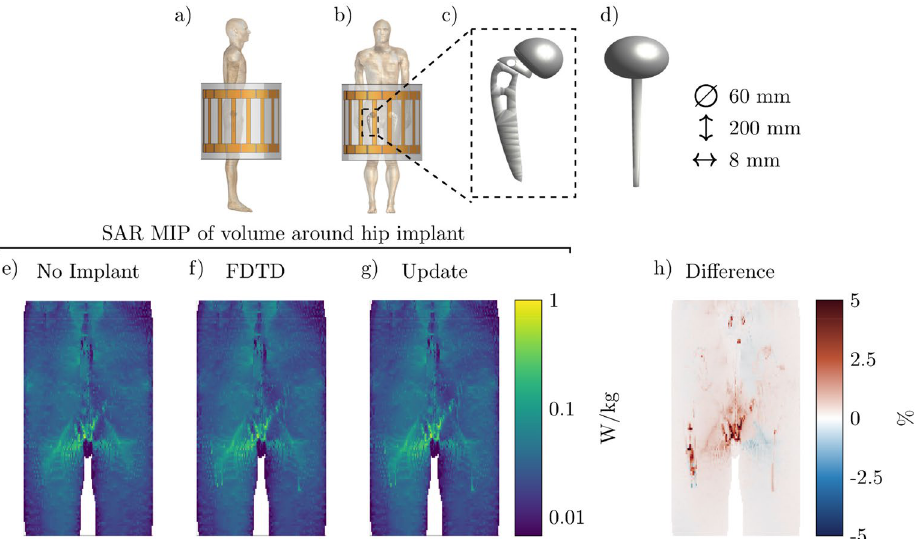
Figure 6. Proposed method applied to calculate the SAR increase for a double hip implant. ( a ) and ( b ) Sagittal and coronal view of the simulated setup, respectively. ( c ) and ( d ) The model of the simulated hip implant. ( e ) The MIP of the local SAR without the hip implant. ( f ) and ( g ) The MIPs of the local SAR with the implant present using the FDTD and the proposed method respectively. ( h ) The MIPs of the difference between the FDTD and the proposed